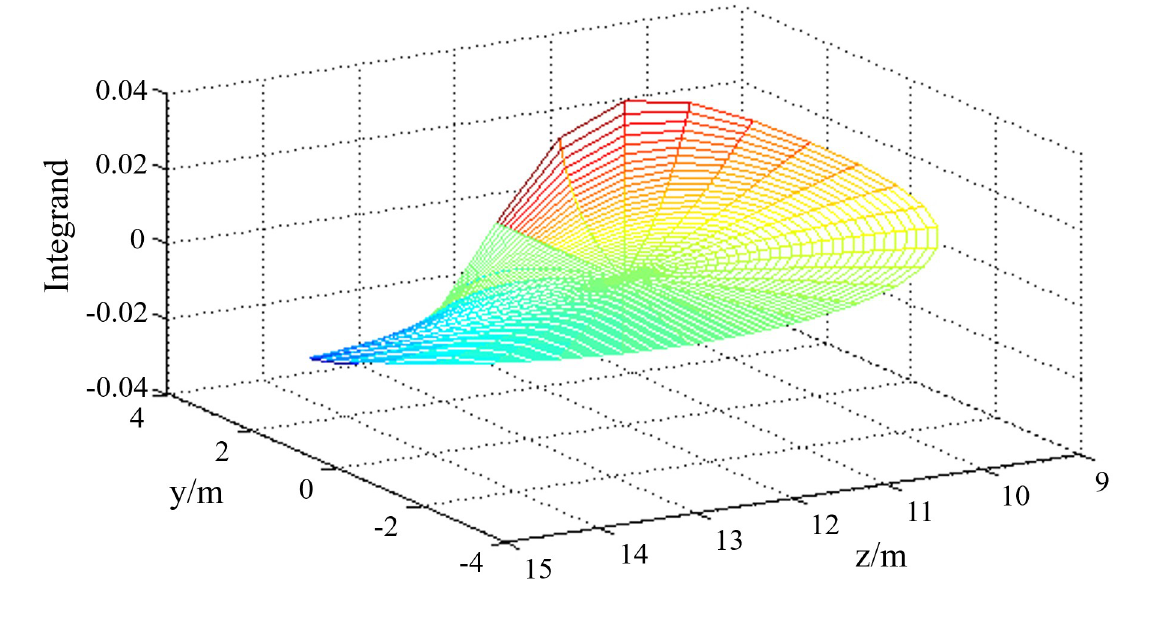
Fig 2. The numerical integration of I w